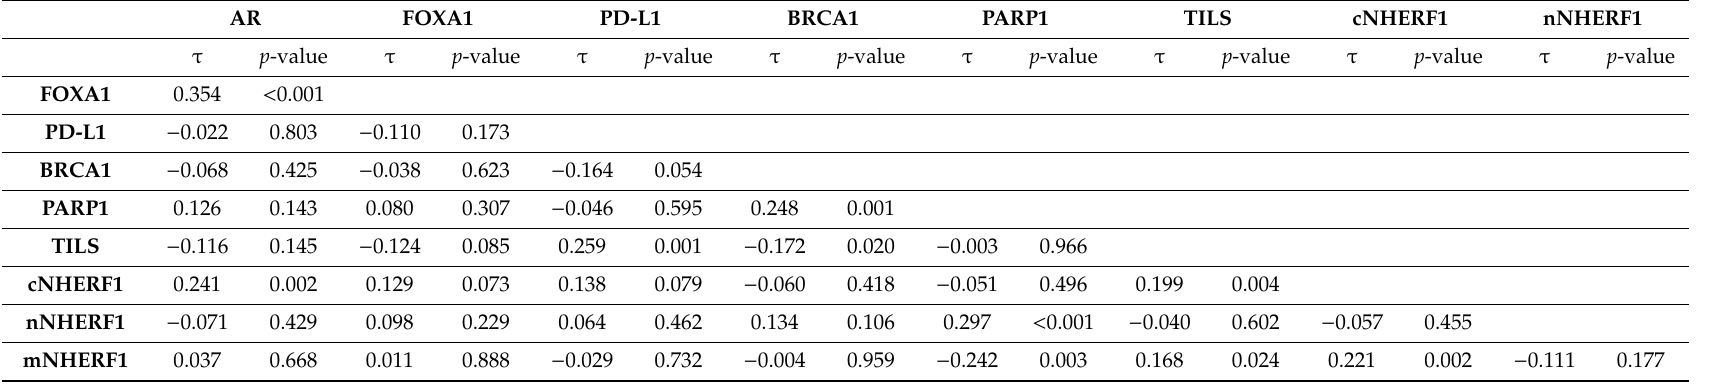
Table 1. Non-linear relationship between two continuous variables assessed by the Kendall rank